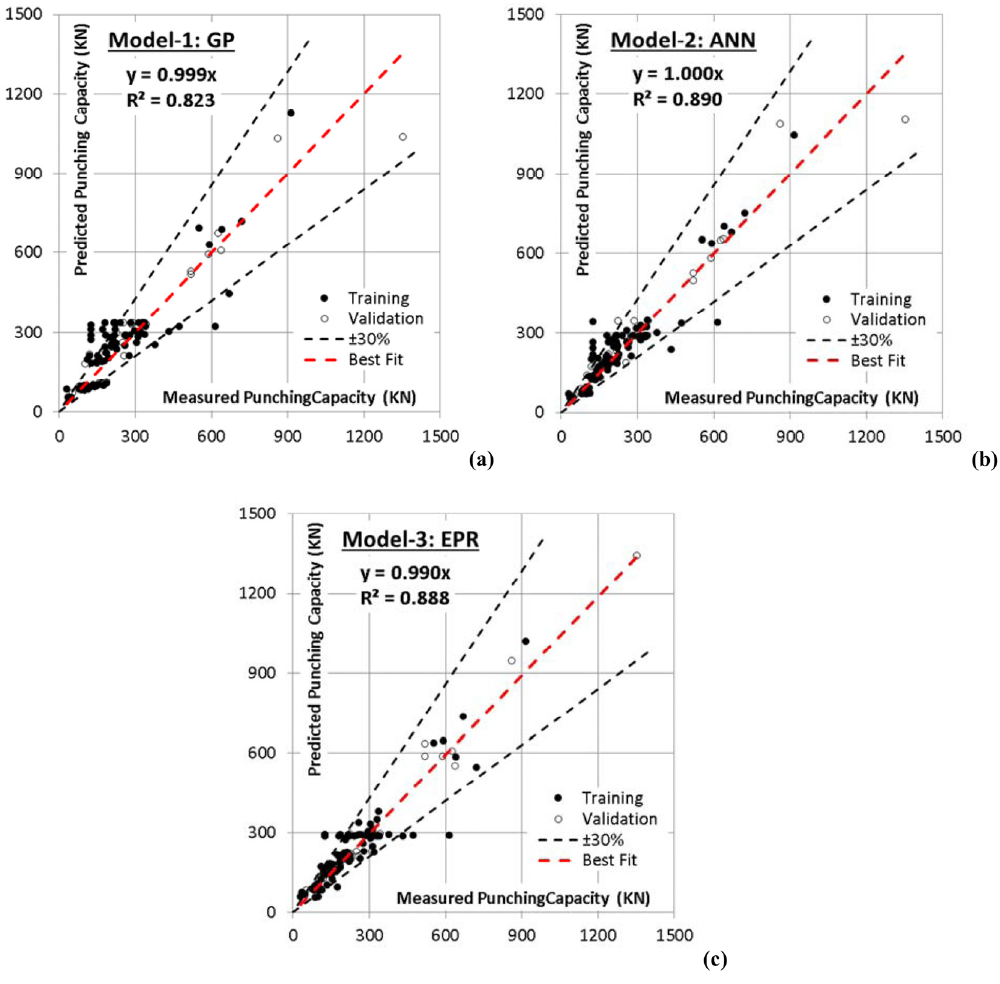
Figure 5. Relative relationship between predicted and calculated ( V u ) values using the developed models, ( a ) GP, ( b ) ANN, ( c ) EPR Table 5. Weights matrix for the developed ANN model. Hidden